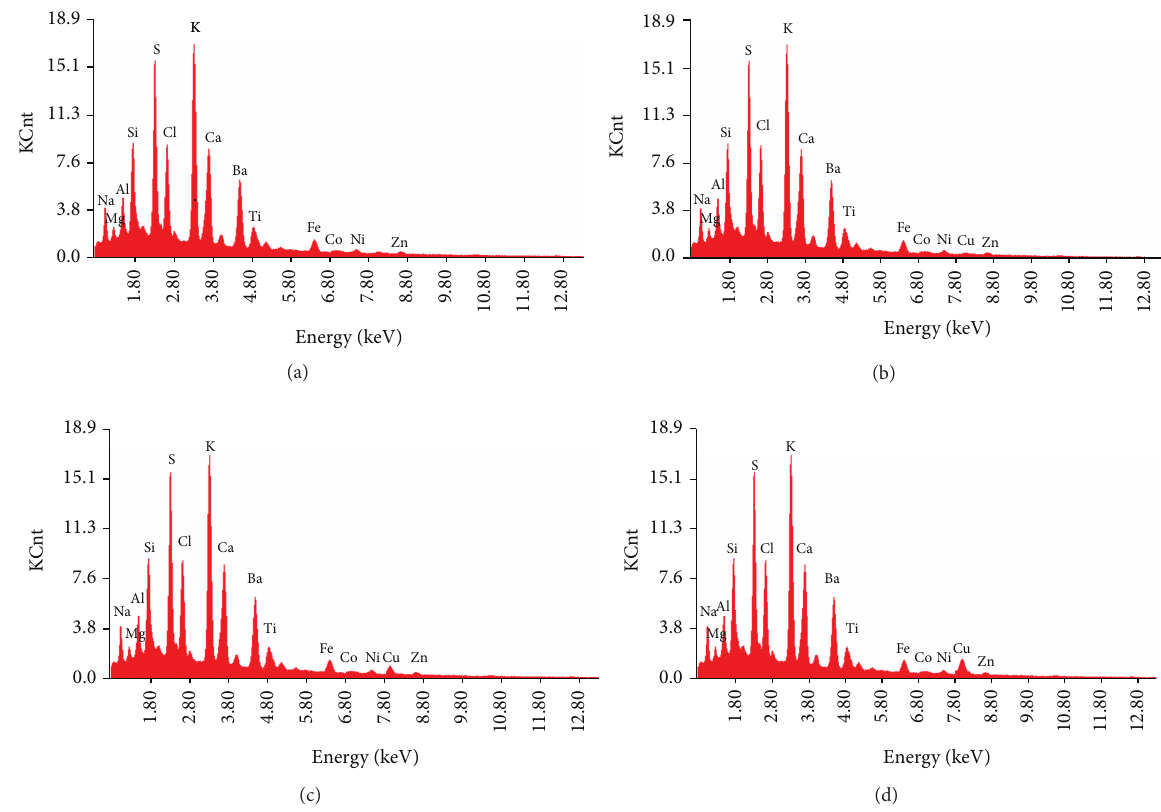
Figure 1: EDAX for PU (a), CuPc(1%)/PU (b), CuPc(15%)/PU (c), and CuPc(30%)/PU (d), respectively.